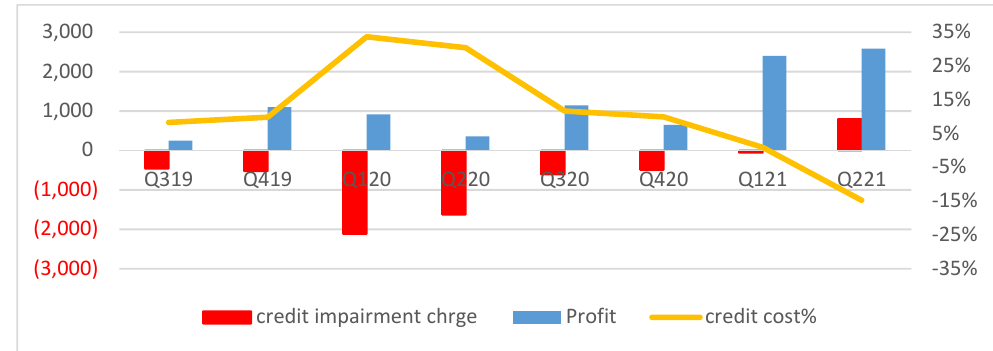
Figure 2. Barclays Group credit cost percentage (credit impairment cost divided by total income), Q319 to Q221.